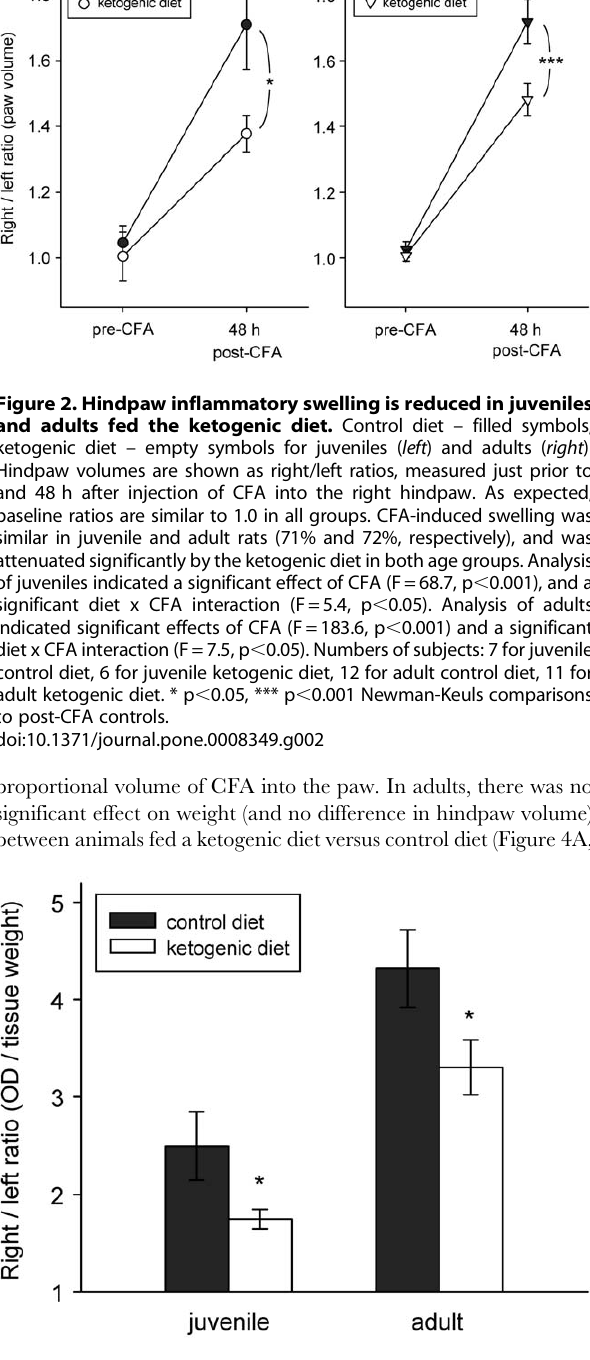
Figure 3. CFA-induced plasma extravasation is reduced in juvenile and adult rats fed the ketogenic diet. Control diet – solid bar, ketogenic diet – open bar for juveniles ( left ) and adults ( right ). Values are shown as right/left ratios and so would be near 1.0 for untreated animals. CFA-induced plasma extravasation was attenuated significantly by a ketogenic diet in juvenile and adult rats; CFA-induced plasma extravasation was lower overall in juveniles. *p , 0.05, t-test comparisons to age-matched controls. Number of subjects: 5 for juvenile control diet, 6 for juvenile ketogenic diet, 10 for adult control diet, 11 for adult ketogenic